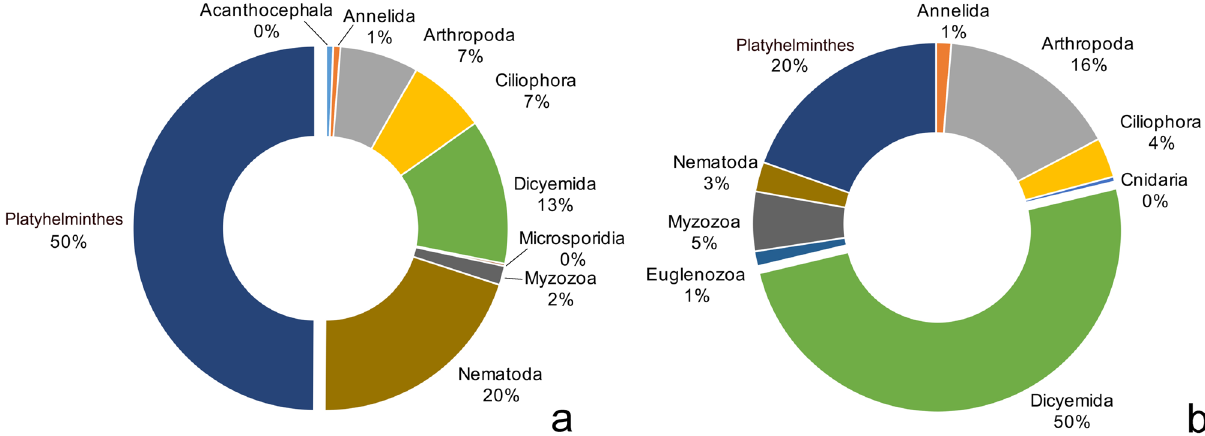
Figure 1. Number of host-parasite associations by parasite phyla in the two main groups of cephalopod hosts, Decapodiformes ( a ) and Octopodiformes ( b